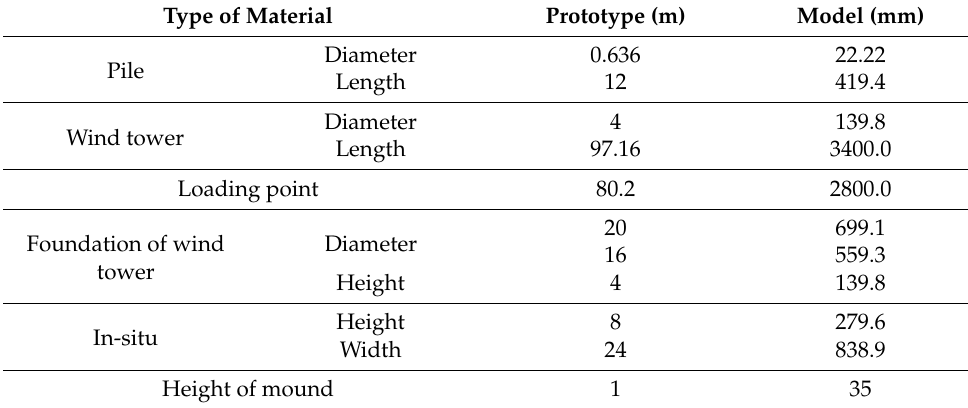
Table 2. Material properties for experiments.